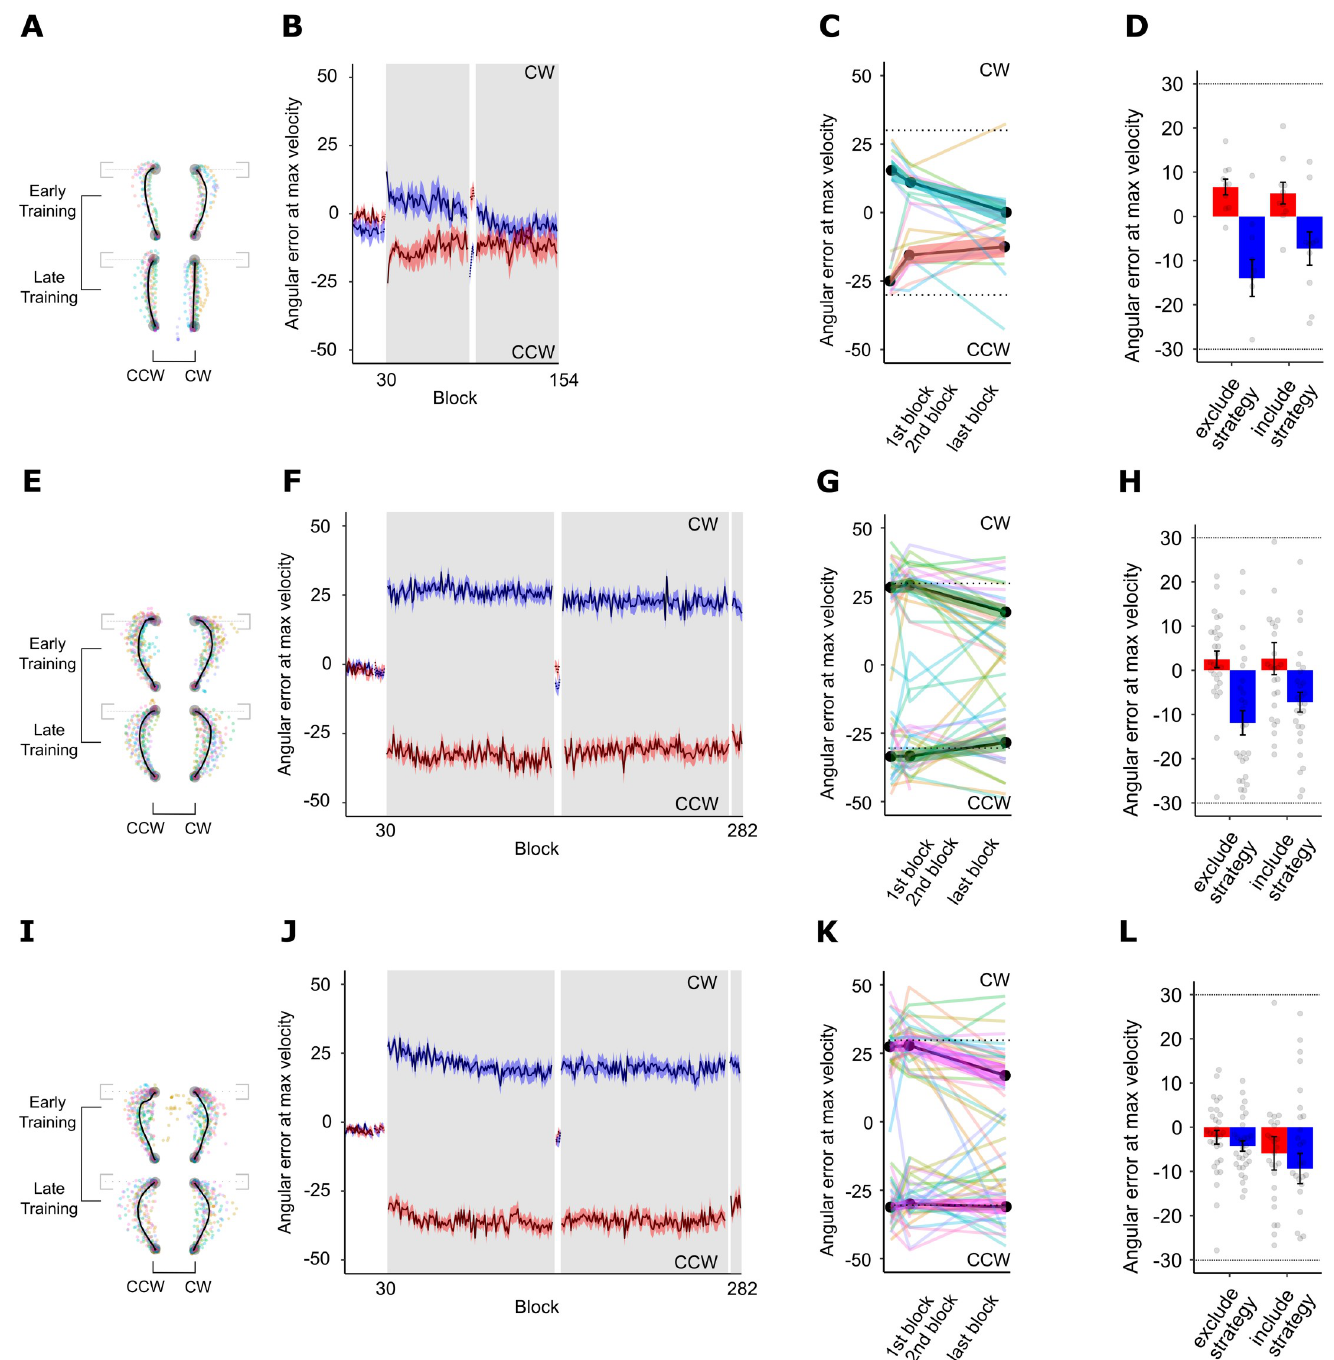
Fig 3. Experiment 1a performance. A. Averaged hand-cursor trajectories for CW- and CCW-only control groups. Coloured translucent dots represent individual trajectories. B. Visuomotor adaptation across all training blocks for CW- and CCW-only control groups. The learning curve for the CW-only group is in blue, and the CCW-only group in red. C. Truncated visuomotor adaptation across training for CW- and CCW-only control groups. Colored translucent lines represent individual learning curves for CW- and CCW-only control groups. D. Reach aftereffects in post-training for CW- and CCW-only control groups. Grey dots represent individual participant errors. Red bars represent CW errors and blue bars represent CCW errors. Dashed lines represent rotation magnitude experienced during training (30˚ CW and 30˚ CCW). Error bars represent SEM. E. Averaged hand-cursor trajectories for the Active follow-through group. F. Visuomotor adaptation across training blocks for the Active follow-through group. G. Truncated visuomotor adaptation across training for the Active follow-through group. H. Reach aftereffects in post-training for the Active follow-through group. I. Averaged hand-cursor trajectories for the Passive follow-through group. J. Visuomotor adaptation across training blocks for the Passive follow-through group. K. Truncated visuomotor adaptation across training for the Passive follow-through group. L. Reach aftereffects in post-training for the Passive follow-through group. https://doi.org/10.1371/journal.pone.0253948.g003 PLOS ONE | https://doi.org/10.1371/journal.pone.0253948 July 8,